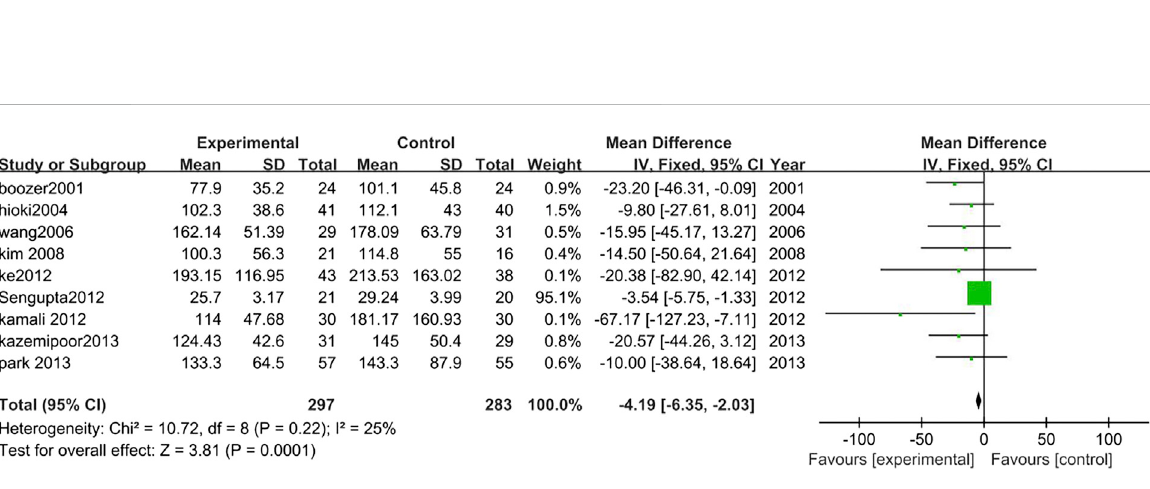
FIGURE 8 Forest plot of TG. Comparison: TCM treatment vs. placeo or blank